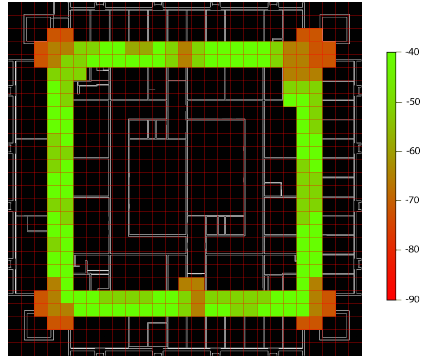
Figure 7. Mean RSSI map of fingerprints collected with AR application